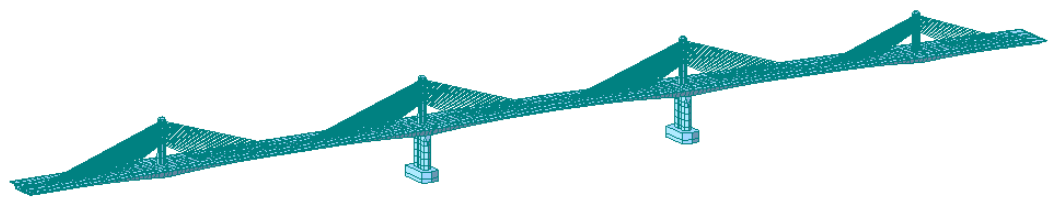
Figure 3. Finite element calculation model.